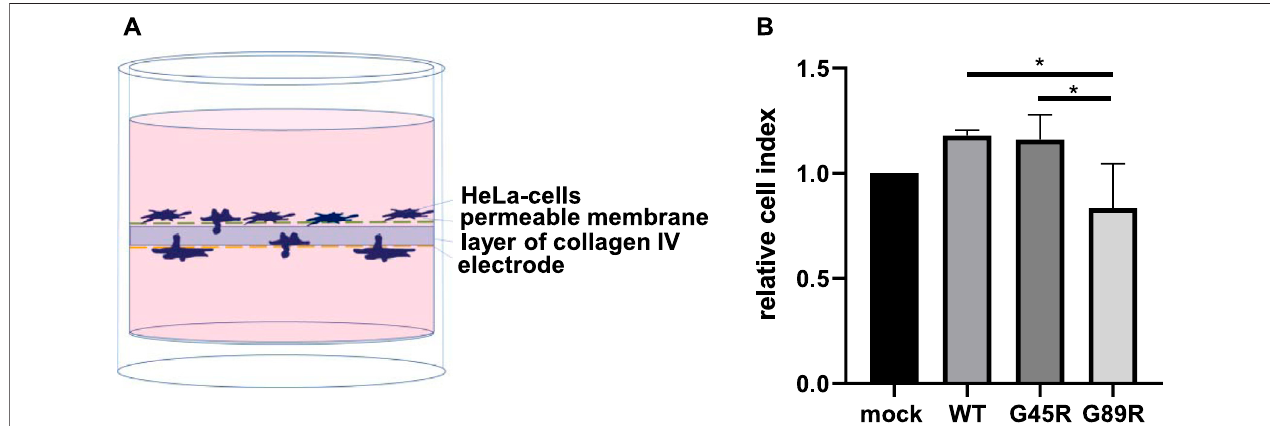
FIGURE 6 | Cancer cell invasion assay through collagen IV matrix. (A) HeLa cells were transfected and seeded into the upper chamber of the well, and the impedanceoftheelectrodelocatedatthebottomofthewellwasmeasuredfor24 h.AnincreaseinimpedancewasequaltocellinvasionthroughthelayerofcollagenIV. (B) Quanti fi cation of the results demonstrates that the expression of G89R reduced the invasiveness signi fi cantly. Values of the different meprin β variants were normalized to values of mock-transfected cells, which were set as 1. Data are presented as means ± sd, and statistical analysis was assessed by the one-way ANOVA followed by Tukey ’ s post-test from three biologic replicates. * p < 0.05, ** p < 0.01, *** p <